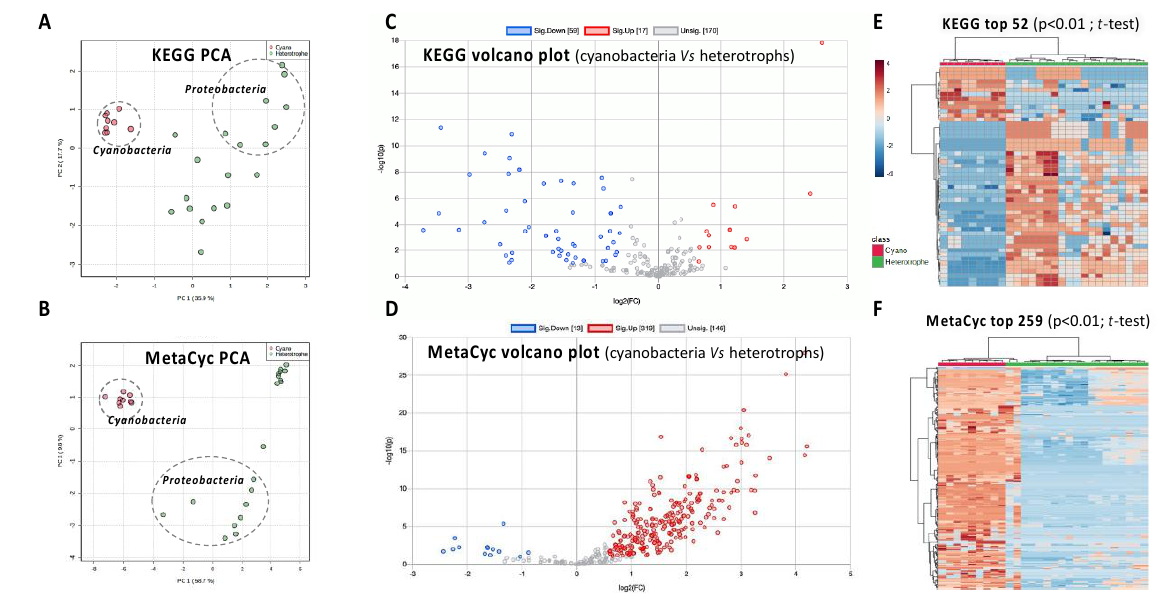
Figure 5. Functional metagenomics of the cyanosphere from the nine cyanobacterial strain and their cyanosphere according to KEGG ( A , C, and E ) and MetaCyc ( B , D, and F ) database interrogation. ( A ) Principal Component Analysis based on KEGG pathway completeness (%age) in cyanobacteria and heterotroph metagenomic sequences. ( B ) Principal Component Analysis based on MetaCyc pathway completeness (%age) in cyanobacteria and heterotroph metagenomic sequences. Dotted ellipse indicates Cyanobacteria and Proteobacteria metagenomes from the nine cyanobacterial strains. ( C ) Volcano plot of individual KEGG pathways completeness (%age) comparing cyanobacteria vs. heterotroph bacteria metagenomes. ( D ) Volcano plot of individual MetaCyc pathways completeness (%age) comparing cyanobacteria vs. heterotroph bacteria metagenomes. Functional pathway significantly over- and under-represented in cyanobacteria are indicated in red and blue, respectively. ( E ) Heatmap with hierarchical classification of KEGG pathway completeness (relative %age indicated by color scale). ( F ) Heatmap with hierarchical classification of MetaCyc pathway completeness (%age). Cyanobacteria and heterotroph metagenomes are indicated in red and green, respectively.